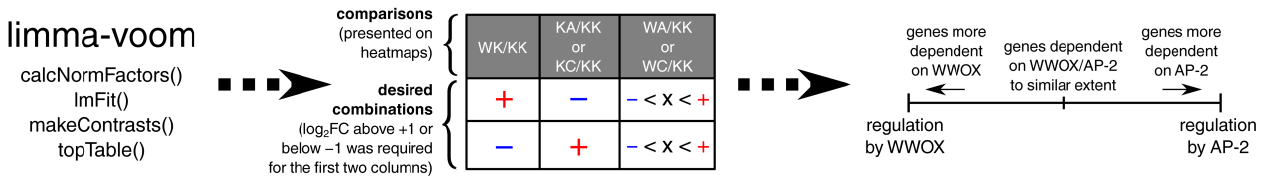
Figure 2. Graphical explanation of the methodology step performed to identify inversely regulated genes across cellular variants.